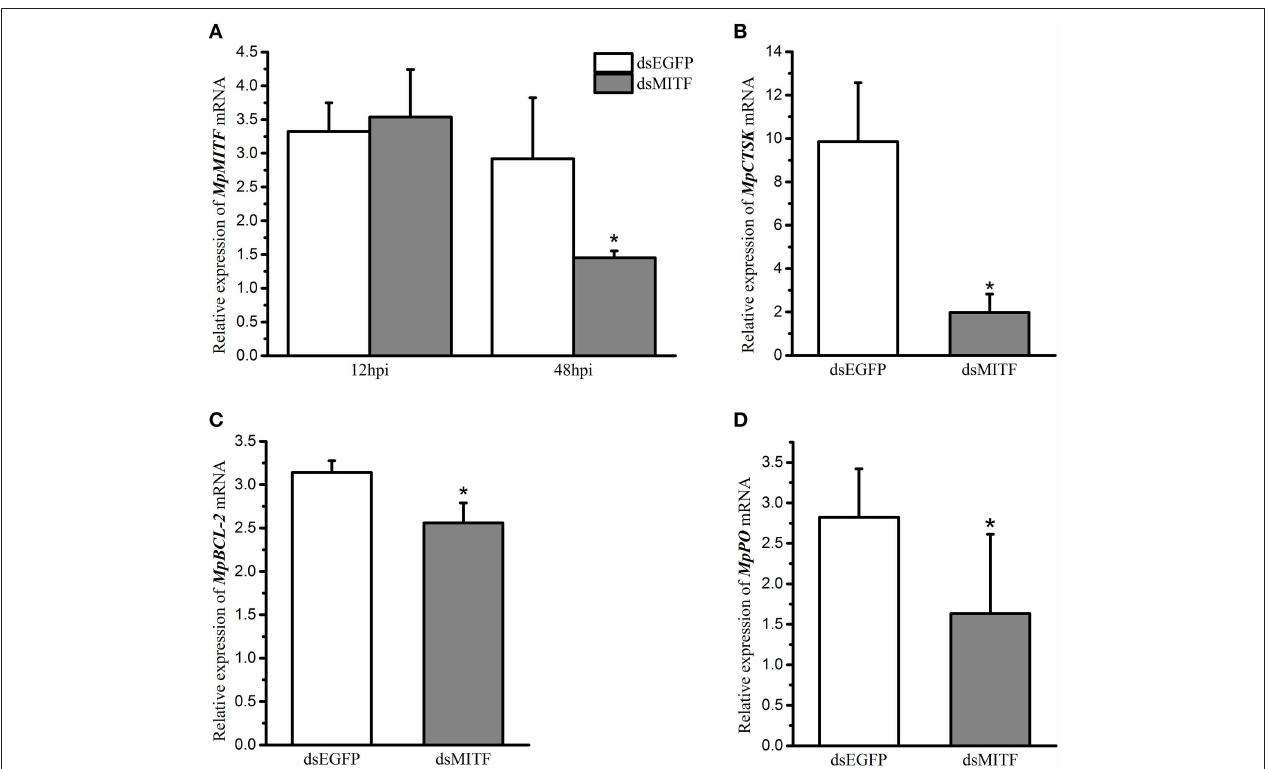
FIGURE 1 | Relative mRNA expression of genes in RNAi experiments by qRT-PCR. (A) Relative mRNA expression of MpMITF in clams injected with dsMITF/dsEGFP at 12 and 48 hpi. (B–D) Relative mRNA expression of potential MITF targets in clams injected with dsMITF/dsEGFP at 48 hpi. Error bars represent the SD. Asterisks (*) represent a significant difference between the dsMITF-injected group and the dsEGFP-injected group ( P < 0.05).